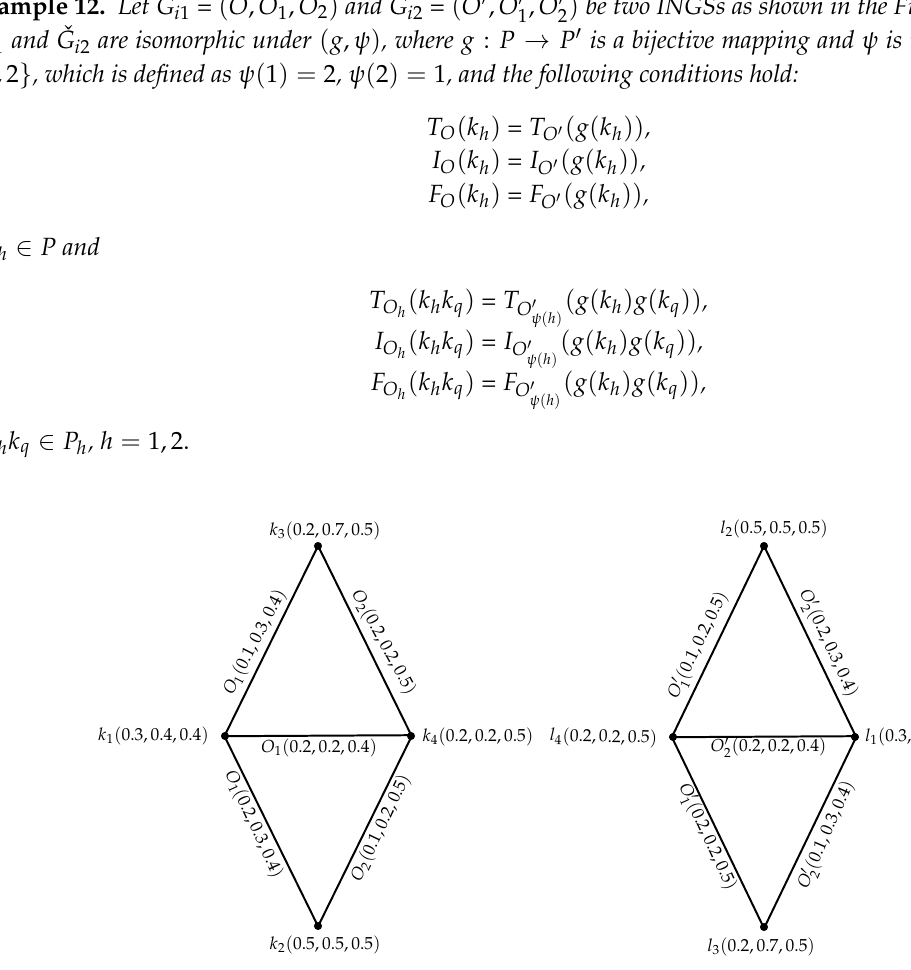
Figure 9. Two isomorphic